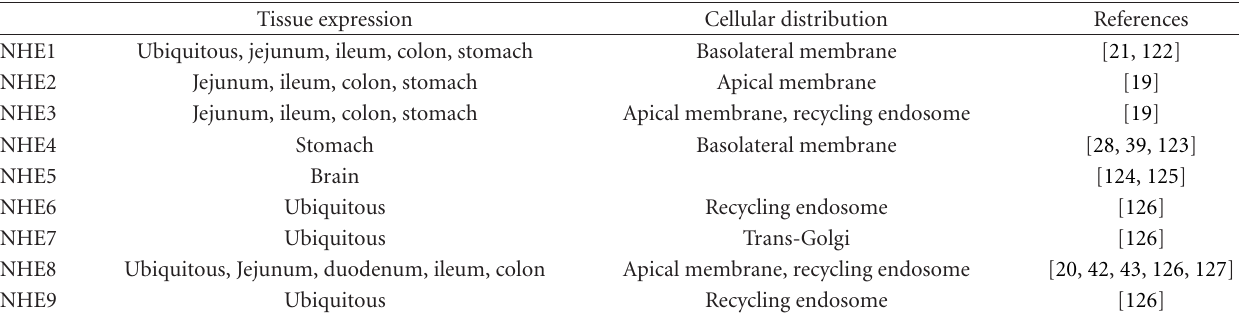
Table 1: Expression of Na + /H + exchangers in the gastrointestinal